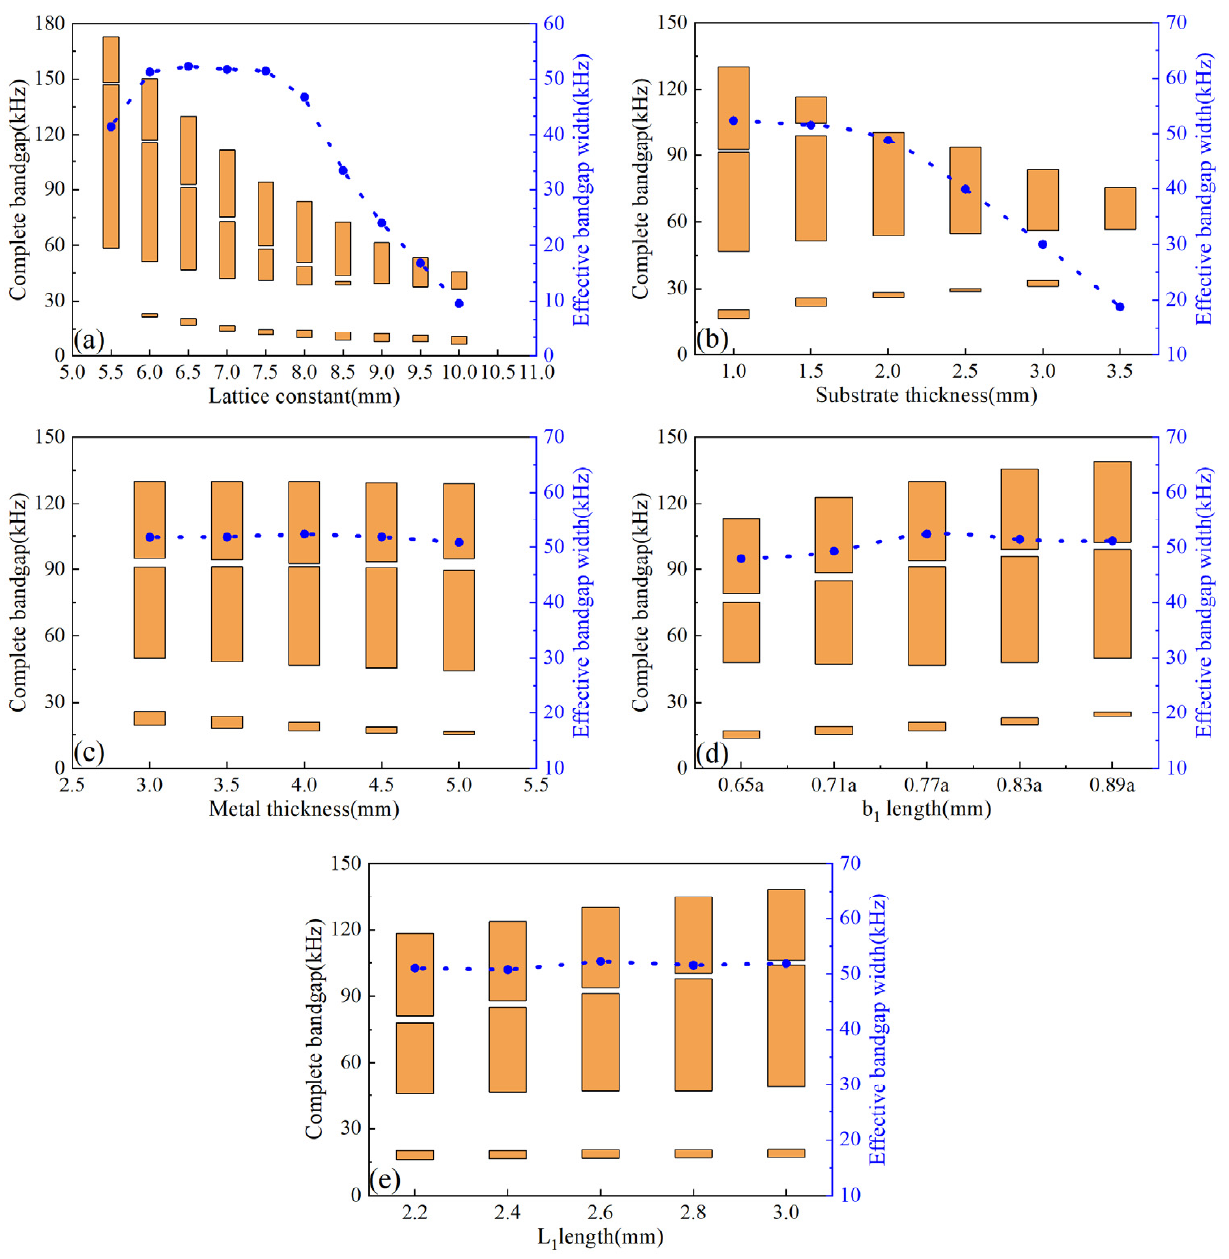
Figure 4. The change in the complete bandgap and the effective bandgap width versus ( a ) the lattice constant a of unit cell, ( b ) the substrate thickness h 1 , ( c ) the metal thickness h 2 , ( d ) the length of b 1 , and ( e ) the length of L 1 .